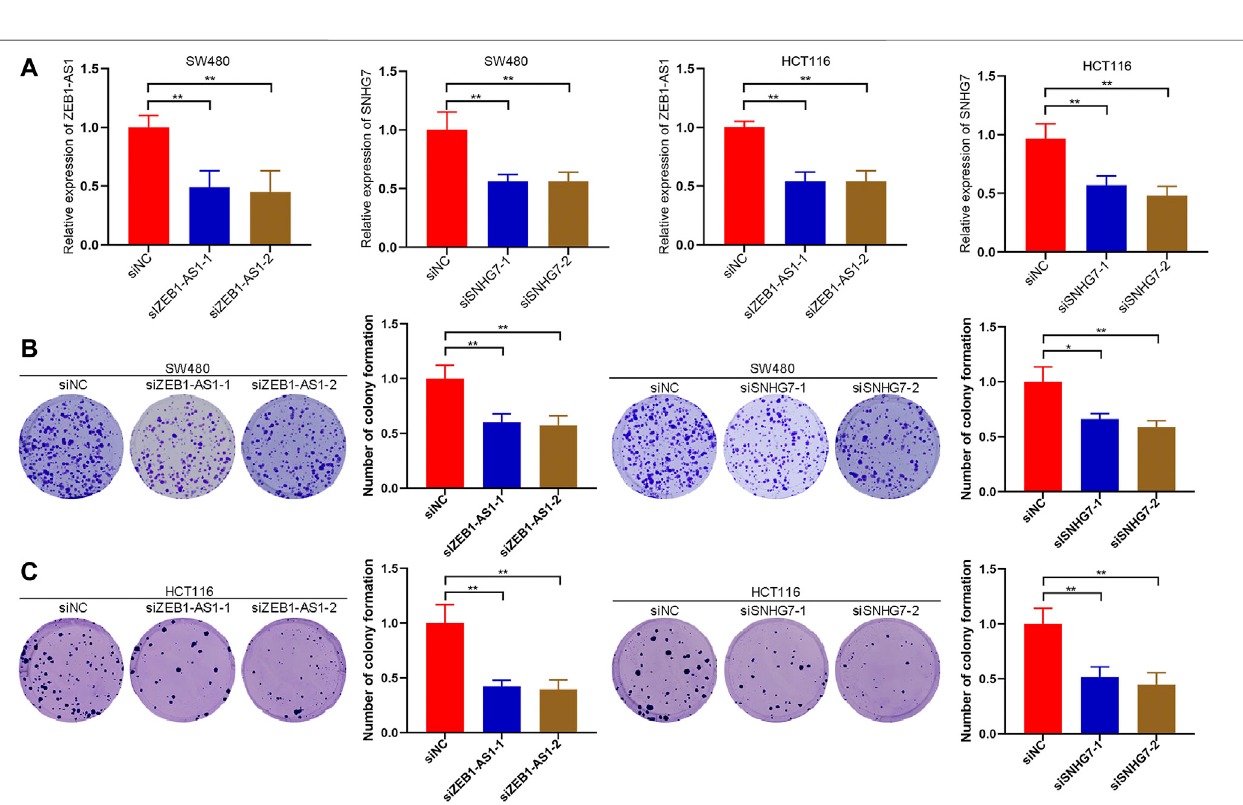
FIGURE 10 | ZEB1-AS1 and SNHG7 silencing inhibited colony formation of CRC cells. (A) RNA interference (RNAi) was performed to deplete the expression of ZEB1-AS1 and SNHG7, and the transfection ef fi cacy was then veri fi ed. (B,C) Colony formation assays suggested that downregulated expression of ZEB1-AS1 and SNHG7 could attenuate the colony formation of SW480 and HCT116 cells.